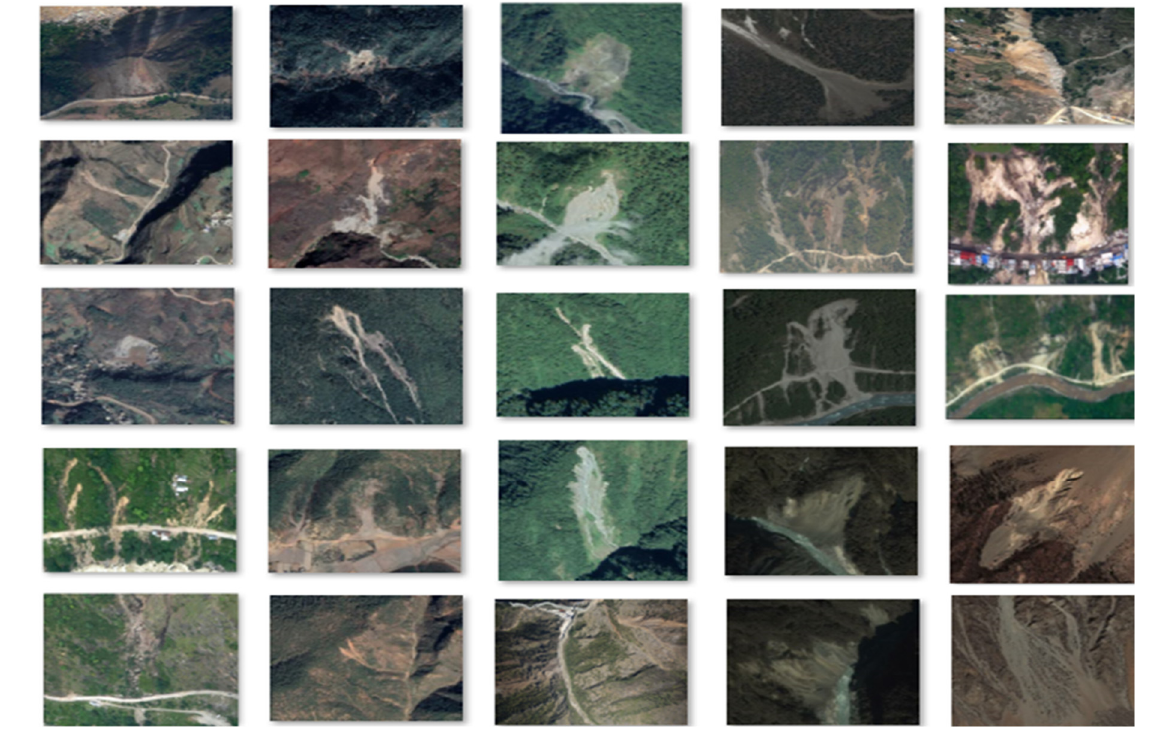
Figure 2. Training dataset samples.